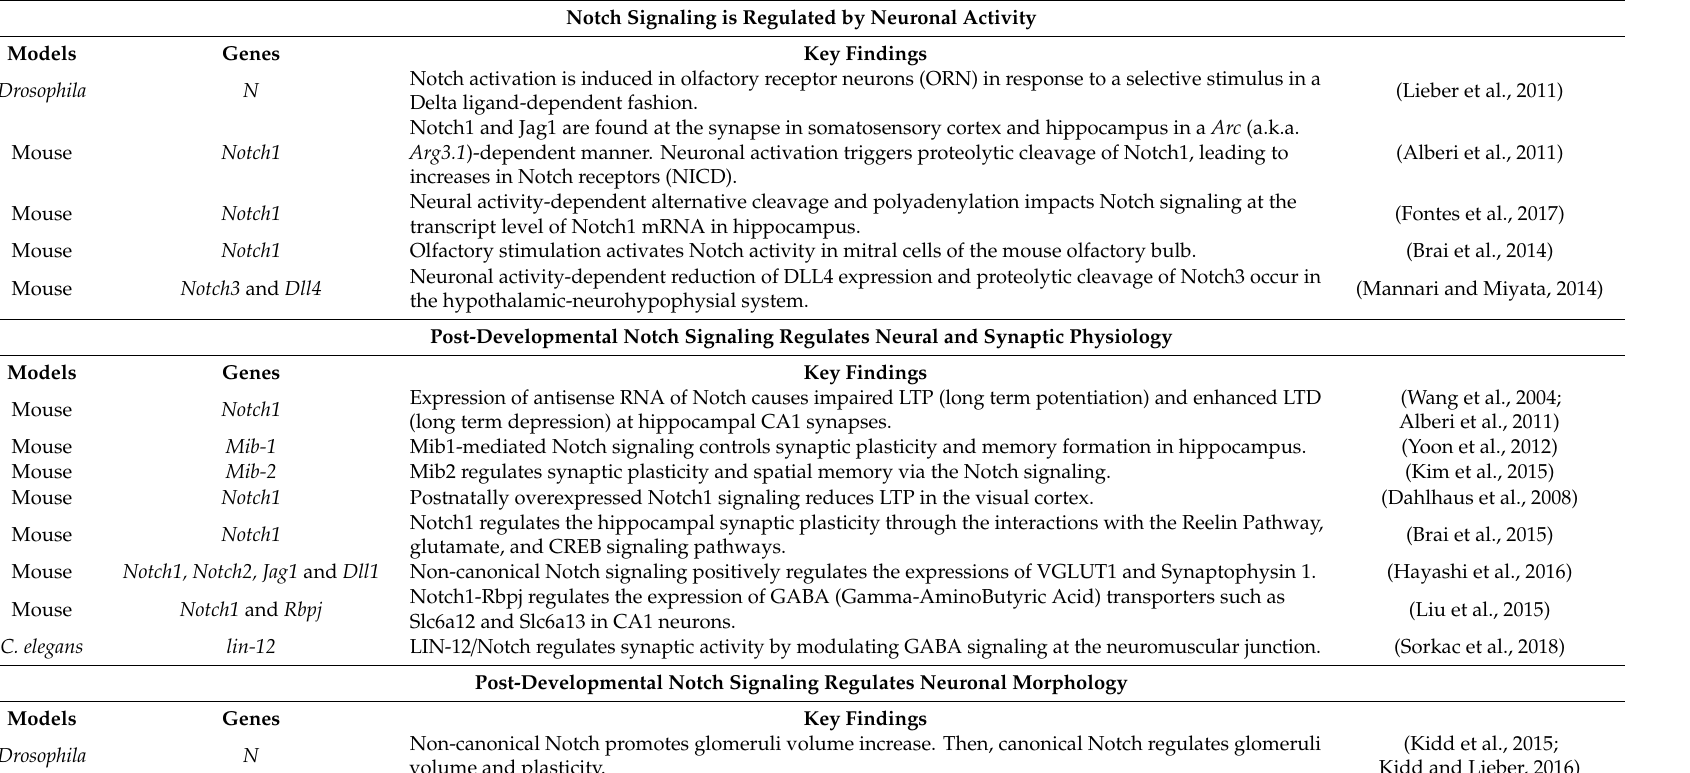
Table 2. Links between post-developmental Notch signaling and neural